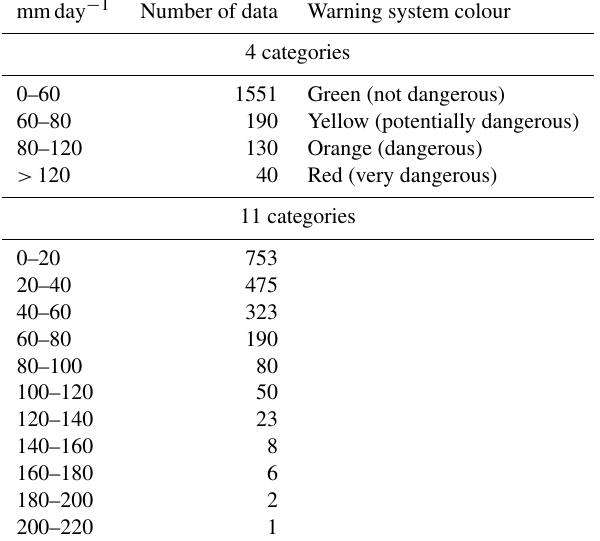
Table 3. Daily precipitation thresholds for contingency tables and number of observed data for each category. For the 4-category con- tingency table, based on Euskalmet colour coded warning system, and for the 11-category one each 20mm.